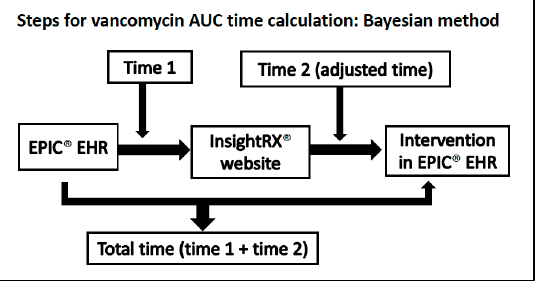
Figure 1. Procedure for vancomycin AUC time calculation using the Bayesian method.